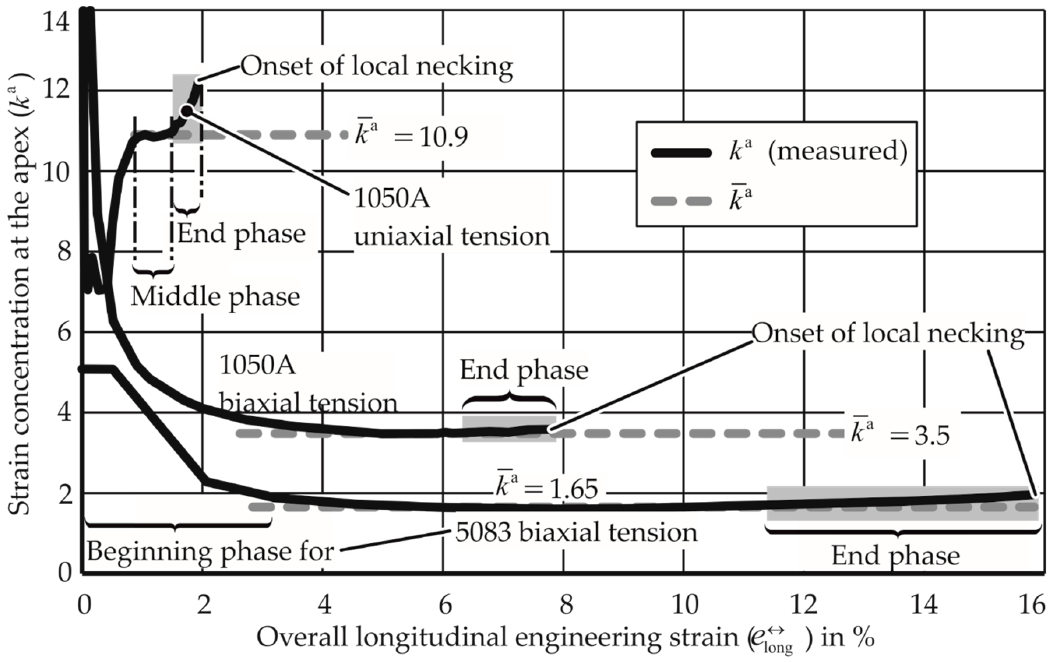
Figure 20. Strain concentration factor at the apex measured during quasi-static forming limit tests.